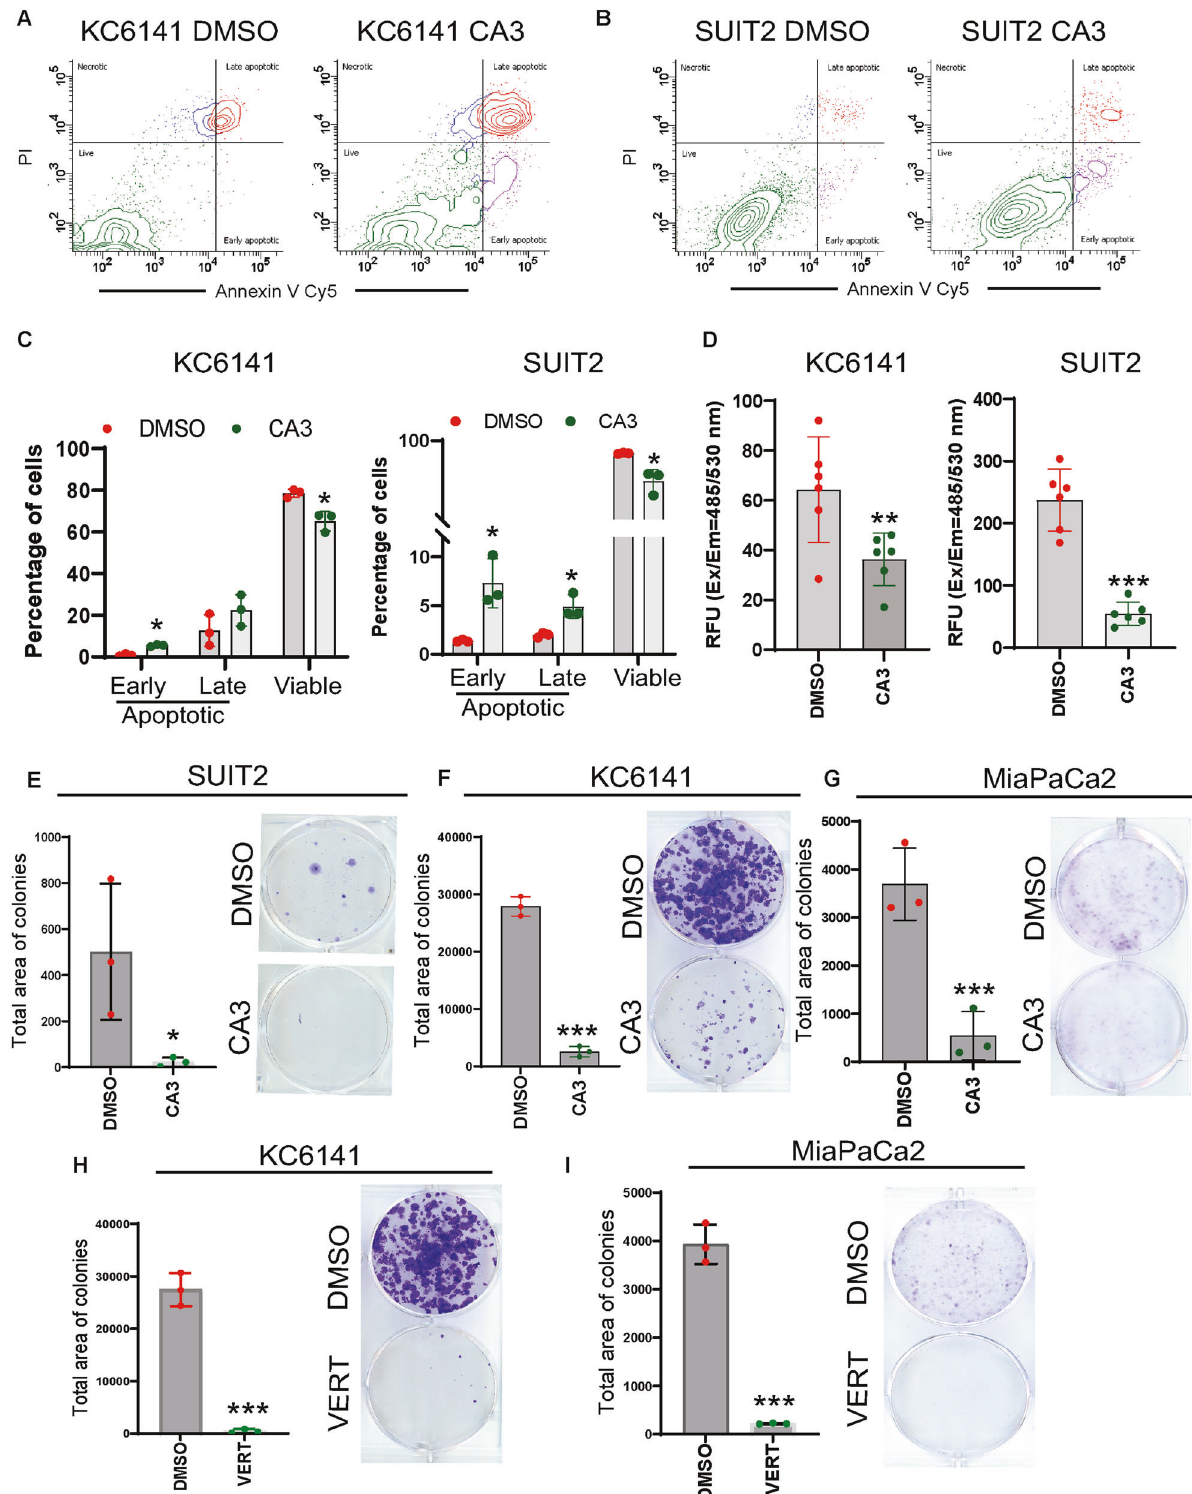
Fig. 5 CA3 and vertepor fi n diminish PC promotion in vitro. A – C Flow cytometry analysis of apoptosis. Cells were stained with Annexin V Cy5 and propidium iodide (PI), followed by fl ow cytometry analysis. Bar graphs show the percentage of apoptotic and viable cells in vehicle control and CA3-treated KC6141 and SUIT2 cells. Data are mean ± SD, n = 3. D Calcein-AM-based proliferation assay. Bar graphs show the relative fl uorescence units (RFU). Data are mean ± SD, n = 6. E – I Colony formation assay. Five hundred cells (SUIT2, MiaPaCa2, and KC6141) were seeded in six-well plates and allowed to form colonies. These colonies were exposed to vehicle control or CA3 (1 µM, 72 h) or vertepor fi n (2 µM, 72 h). Bar graphs show the total area of the colonies. Data are mean ± SD, n = 3. For all panels, signi fi cance was determined with a student ’ s t test. * p < 0.05, ** p < 0.01, *** p < 0.001, ns: non-signi fi cant, p > 0.05.